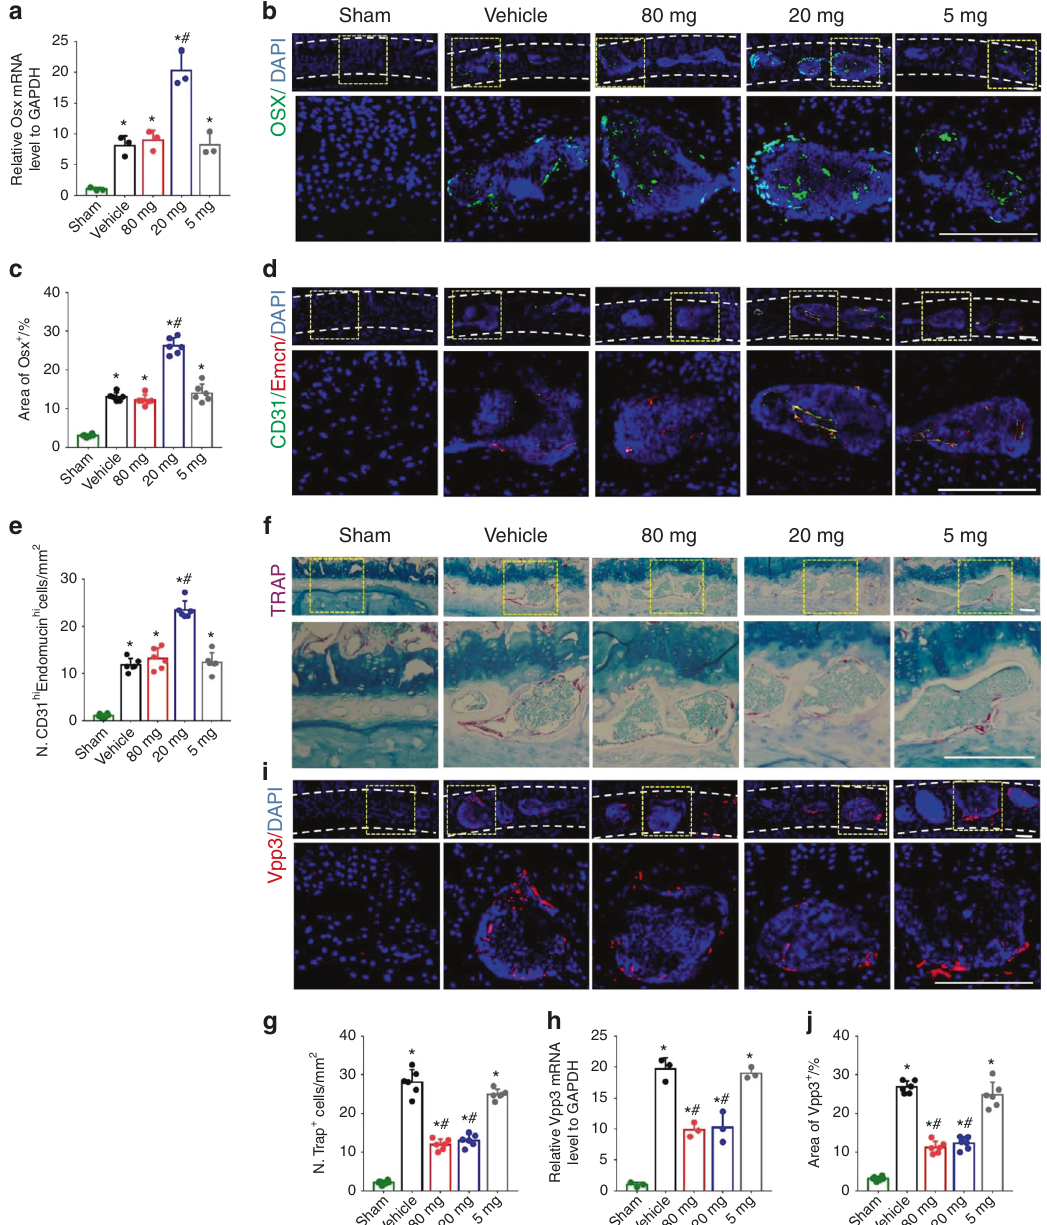
Fig. 3 Low-dose celecoxib induced new bone formation in porous endplates. a Quantitative analysis of OSX mRNA expression in lumbar endplates at 2 and 4 weeks after celecoxib or vehicle treatment by qRT-PCR. b Representative images of immunostaining of osterix (green) and DAPI (blue) in the L4-L5 caudal endplates at 2 weeks after celecoxib or vehicle treatment. c Quantitative analysis of the percentage of osterix + area in lumbar endplates. d Representative images of immunostaining of CD31 (green), endomucin (red), and DAPI (blue) in the L4-L5 caudal endplates at 2 weeks after celecoxib or vehicle treatment. e Quantitative analysis of the number of CD31 hi endomucin hi cells in lumbar endplates. f Representative images of TRAP staining (magenta) in the L4-L5 caudal endplates at 2 weeks after celecoxib or vehicle treatment. g Quantitative analysis of the number of TRAP + cells in lumbar endplates. h Quantitative analysis of Vpp3 mRNA expression in lumbar endplates at 2 and 4 weeks after celecoxib or vehicle treatment by qRT-PCR. i Representative images of immunostaining of Vpp3 (red) and DAPI (blue) in the L4-L5 caudal endplates at 2 weeks after celecoxib or vehicle treatment. j Quantitative analysis of the percentage of Vpp3 + area in lumbar endplates. Scale bars, 50 μ m ( b , d , f , i ). * P < 0.05 compared with the sham group and # P < 0.05 com p ared with the vehicle group. n = 3 per group ( a , h ); n = 6 per group ( c , e , g , j